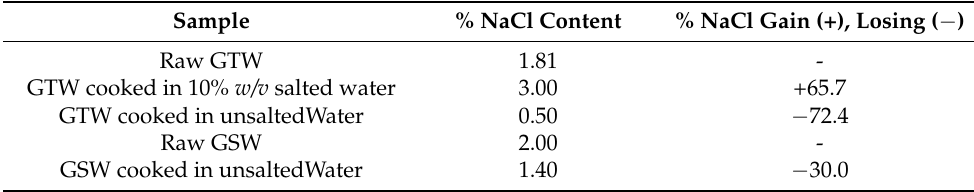
Table 1. NaCl content of raw and cooked GTW and GSW Gnocchi .